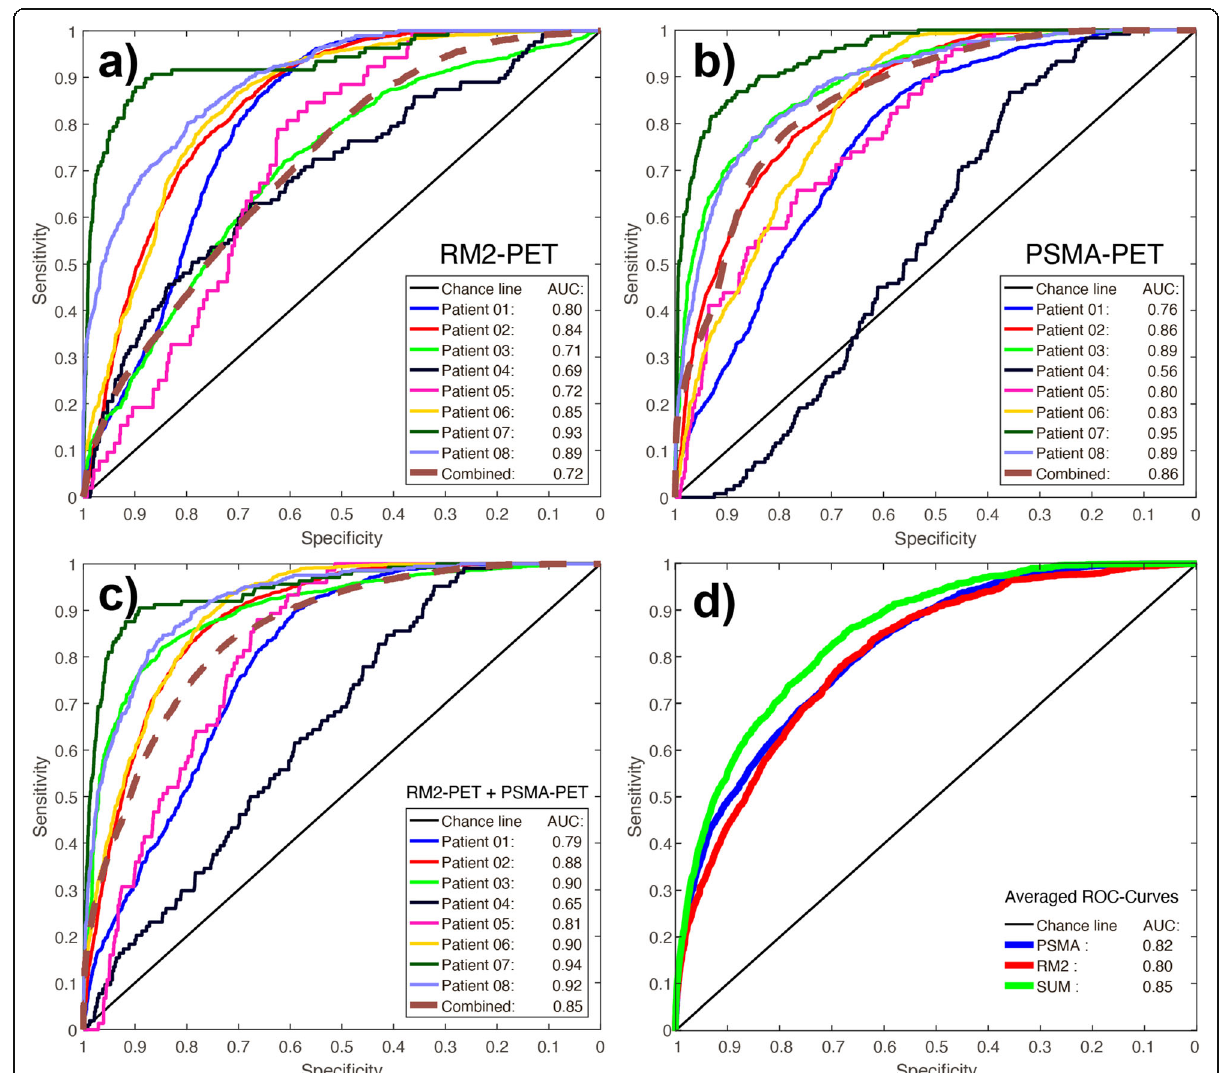
Fig. 3 a Receiver operating characteristic (ROC) curves of a voxel-based comparison of [ 68 Ga]Ga-RM2-PET (RM2-PET) SUV with the 3D-Histo value (1 = tumor, 0 = no tumor) for each patient and, additionally, for all patients ’ voxels combined (brown dashed line). A combined curve calculated overall patients ’ voxels is plotted as a brown dashed line. b ROC curves of a voxel-based comparison of [ 68 Ga]Ga-PSMA-11-PET (PSMA-PET) SUV with the 3D-Histo value, taken from Zamboglou et al . [40] for comparison. c ROC curves for voxel-based summated data of RM2-PET and PSMA- PET scans (RM2 + PSMA) with 3D-Histo value as reference. d Averaged ROC curves for PSMA-PET (blue), RM2-PET (red), and summated data RM2 + PSMA (green) with 3D-Histo value as